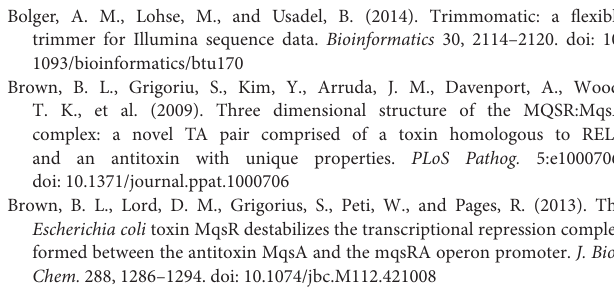
Supplementary Figure 1 | X. fastidiosa transformed with the pXF20 empty vector. Supplementary Figure 2 | Experimental design. Supplementary Figure 3 | Reads of RNA-Seq. Supplementary Figure 4 | Validation RNA-Seq data. Supplementary Table 1 | Bacterial strains and plasmids. Supplementary Table 2 | Primers used for real-time quantitative PCR. Supplementary Table 3 | MqsA-like palindromic sequences (5’-AAC (N)7 GTT-3’) found in the genome of X. fastidiosa 9a5c. Supplementary Table 4 | Genes with the MqsA-like palindromic sequence identified in the RNA-Seq. Supplementary Data Set 1 | Differential gene expression analysis between the M-0/C-0. Supplementary Data Set 2 | Differential gene expression analysis between the M-3/M-0. Supplementary Data Set 3 | Differential gene expression analysis between the C-3/C-0. Supplementary Data Set 4 | Differential gene expression analysis between the downregulated and upregulated genes from the C-3/C-0 and M-3/M-0. Supplementary Data Set 5 | Venn diagram of differentially expressed genes in M-3/M-0 and C-3/C-0. Supplementary Data Set 6 | Functional characterization of proteins encoded by genes downregulated by MqsR in X. fastidiosa from Figure 3 . Supplementary Data Set 7 | Functional characterization of proteins encoded by genes upregulated by MqsR in X. fastidiosa from Figure 3 . Supplementary Data Set 8 | Functional characterization of proteins encoded by genes upregulated by MqsR in X. fastidiosa under copper stress from Figure 5A . Supplementary Data Set 9 | Functional characterization of proteins encoded by genes downregulated by MqsR in X. fastidiosa under copper stress from Figure 5A . Supplementary Data Set 10 | Functional characterization of proteins encoded by unique genes downregulated by MqsR in X. fastidiosa under copper stress from Figure 5B . Supplementary Data Set 11 | Functional characterization of proteins encoded by unique genes upregulated by MqsR in X. fastidiosa under copper stress from Figure 5B